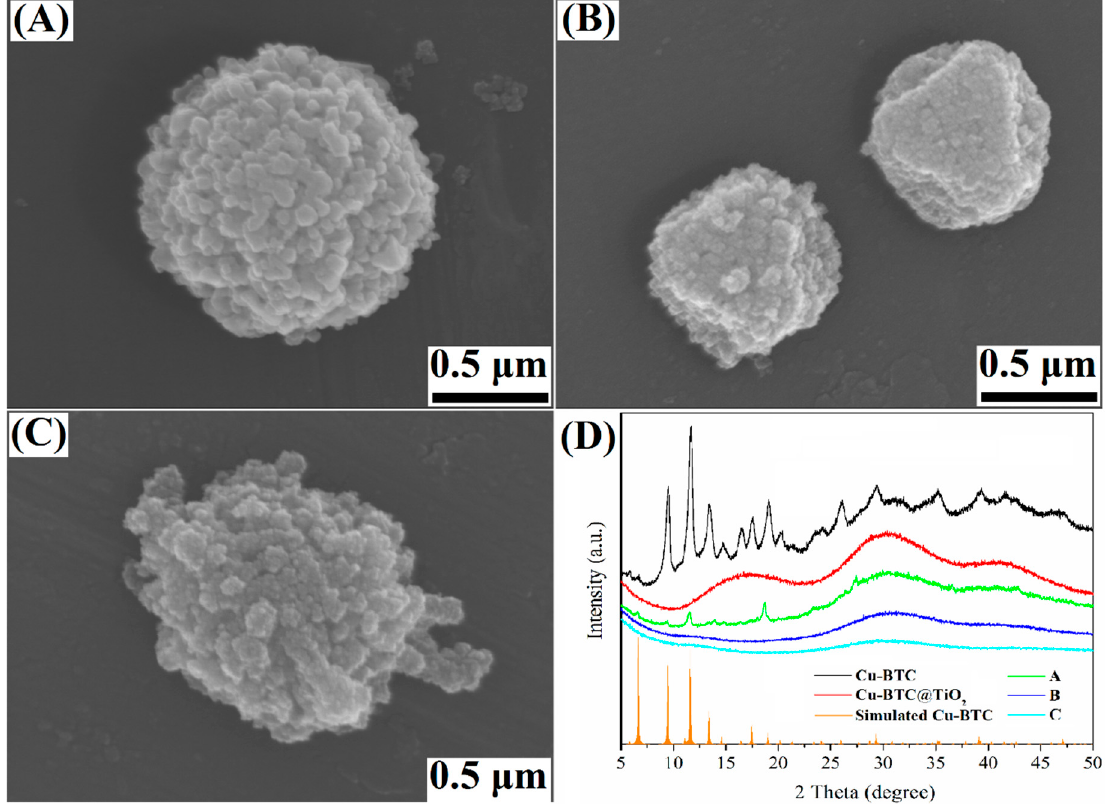
Figure 6. FESEM images of Cu-BTC@TiO 2 prepared with TiF 4 ( A ), 0.1 mL of tetrabutylortotitanate (TBOT) ( B ), methanol ( C ), and corresponding XRD patterns ( D ).